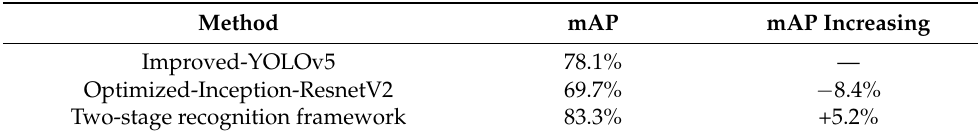
Table 9. Comparison results of two kinds of single-stage identification methods and the two-stage framework of this paper.